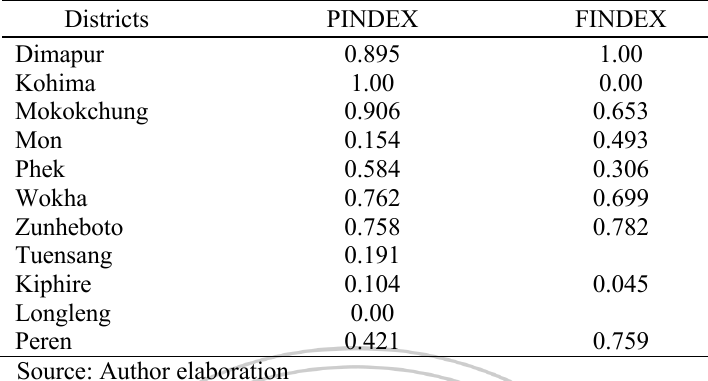
Table 1 : Indices of rural poverty and environmental degradation